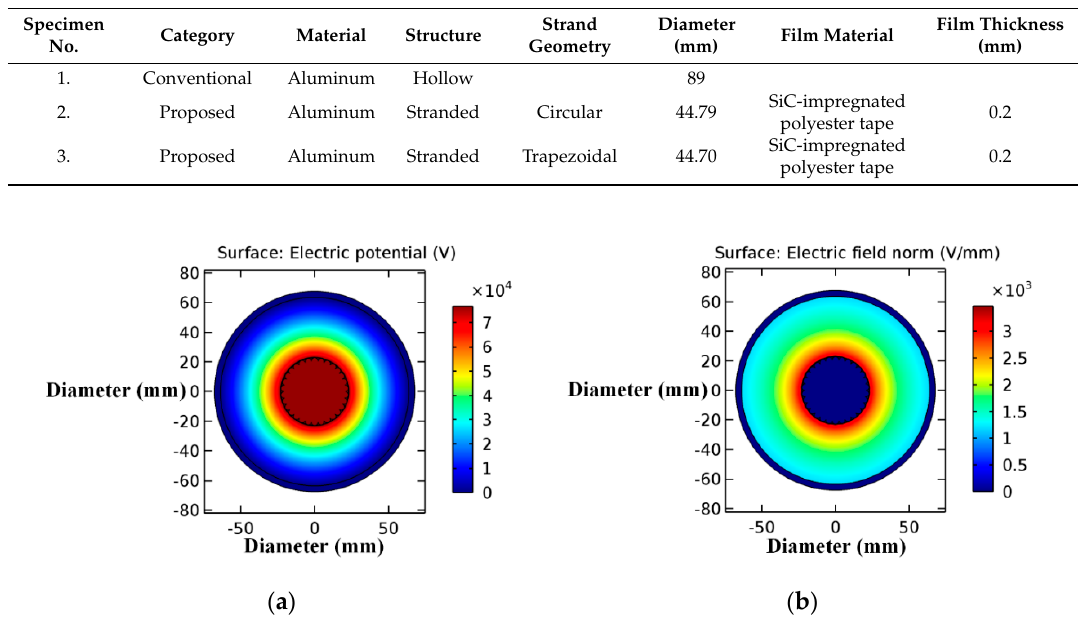
Table 3. Conductor specimens used in the comparative appraisal.